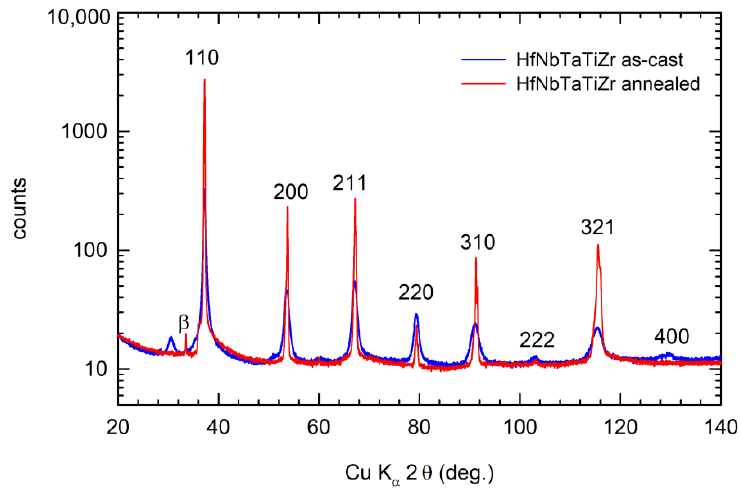
Figure 8. XRD pattern of HfNbTaTiZr alloy in the as-cast state and after annealing at 1200 °C. The label β denotes reflection arising from the Cu K β wavelength.